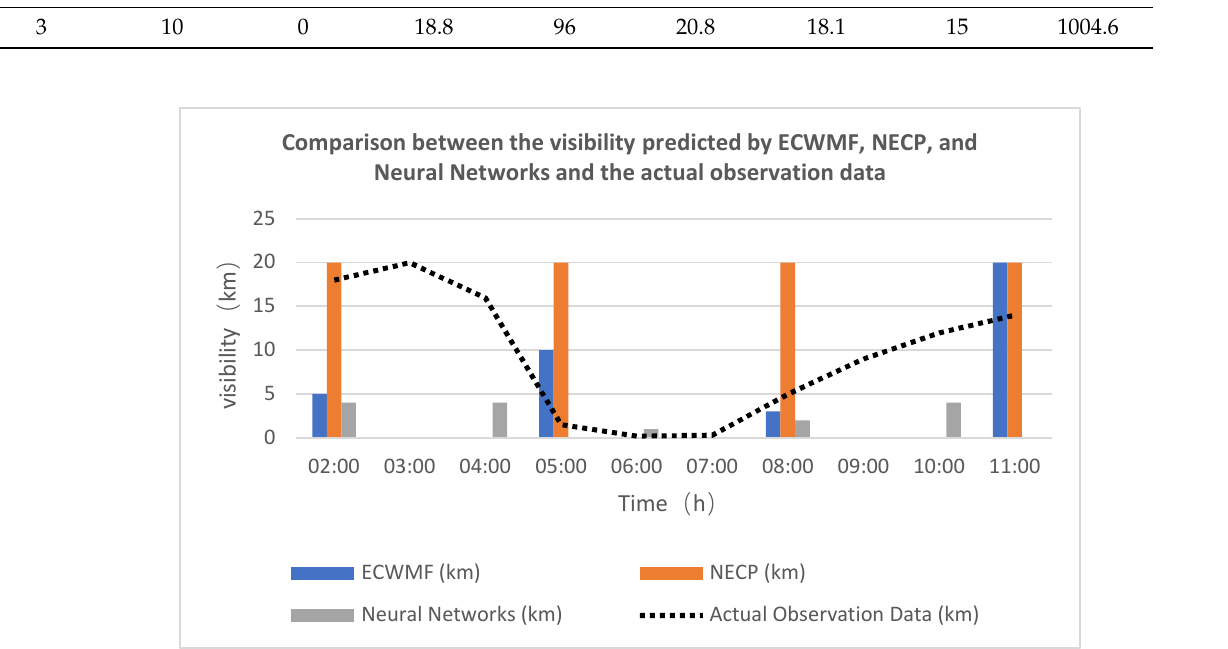
Table 6. Time of initial data: 27 August 2021, at 02:00.